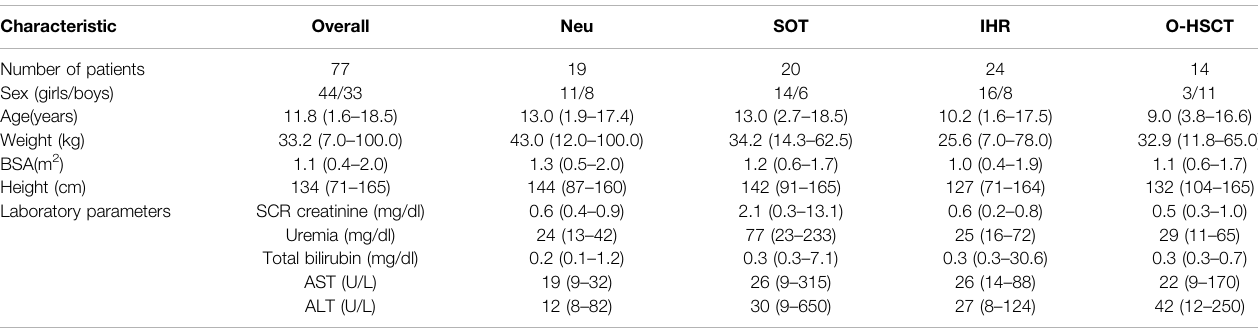
TABLE 2 | Demographic and biochemical features of the study population.